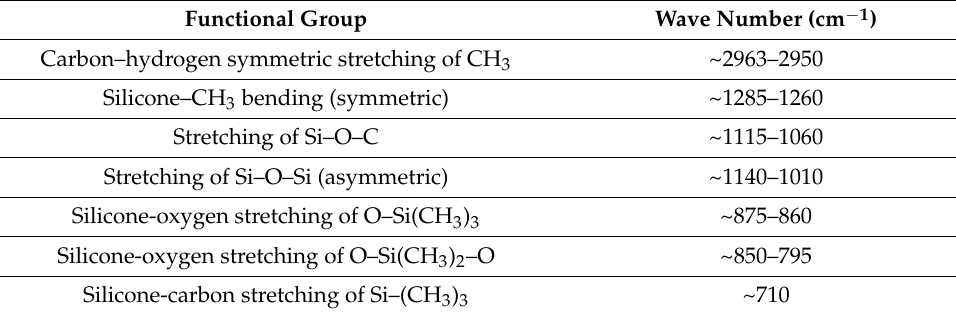
Table 2. Prominent groups and relevant absorption bands.